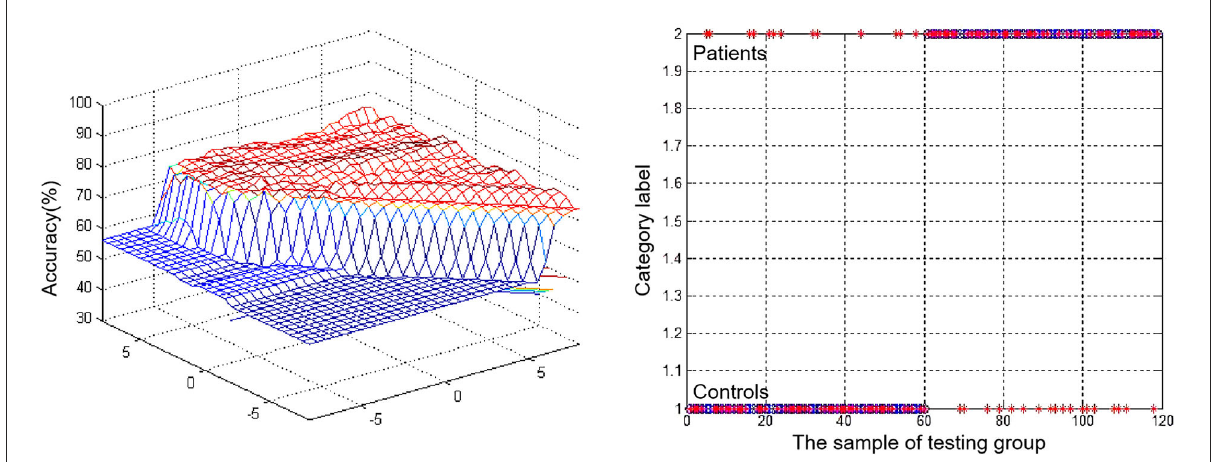
FIGURE3 Visualization of classifications through support vector machine (SVM) using the decreased VMHC values in rMTG to discriminate patients with rTLE from healthy controls. Left: SVM parameters result of 3D view. Right: Classified map of the VMHC values in